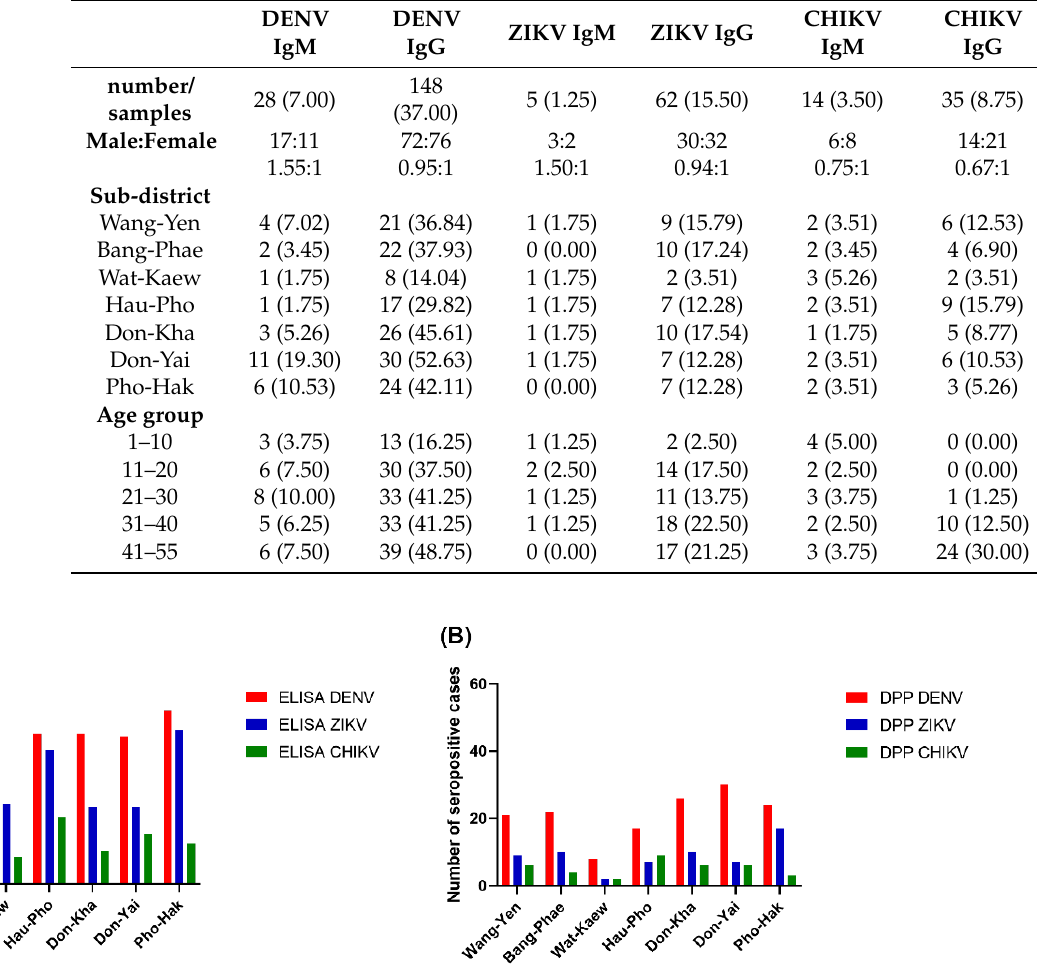
Table 3. Seropositivity for three arboviruses according to DPP ® ZCD system [ n (%)].